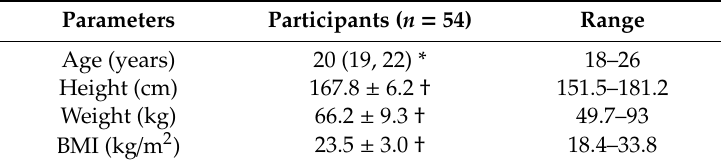
Table 1. Characteristics of the sample population.